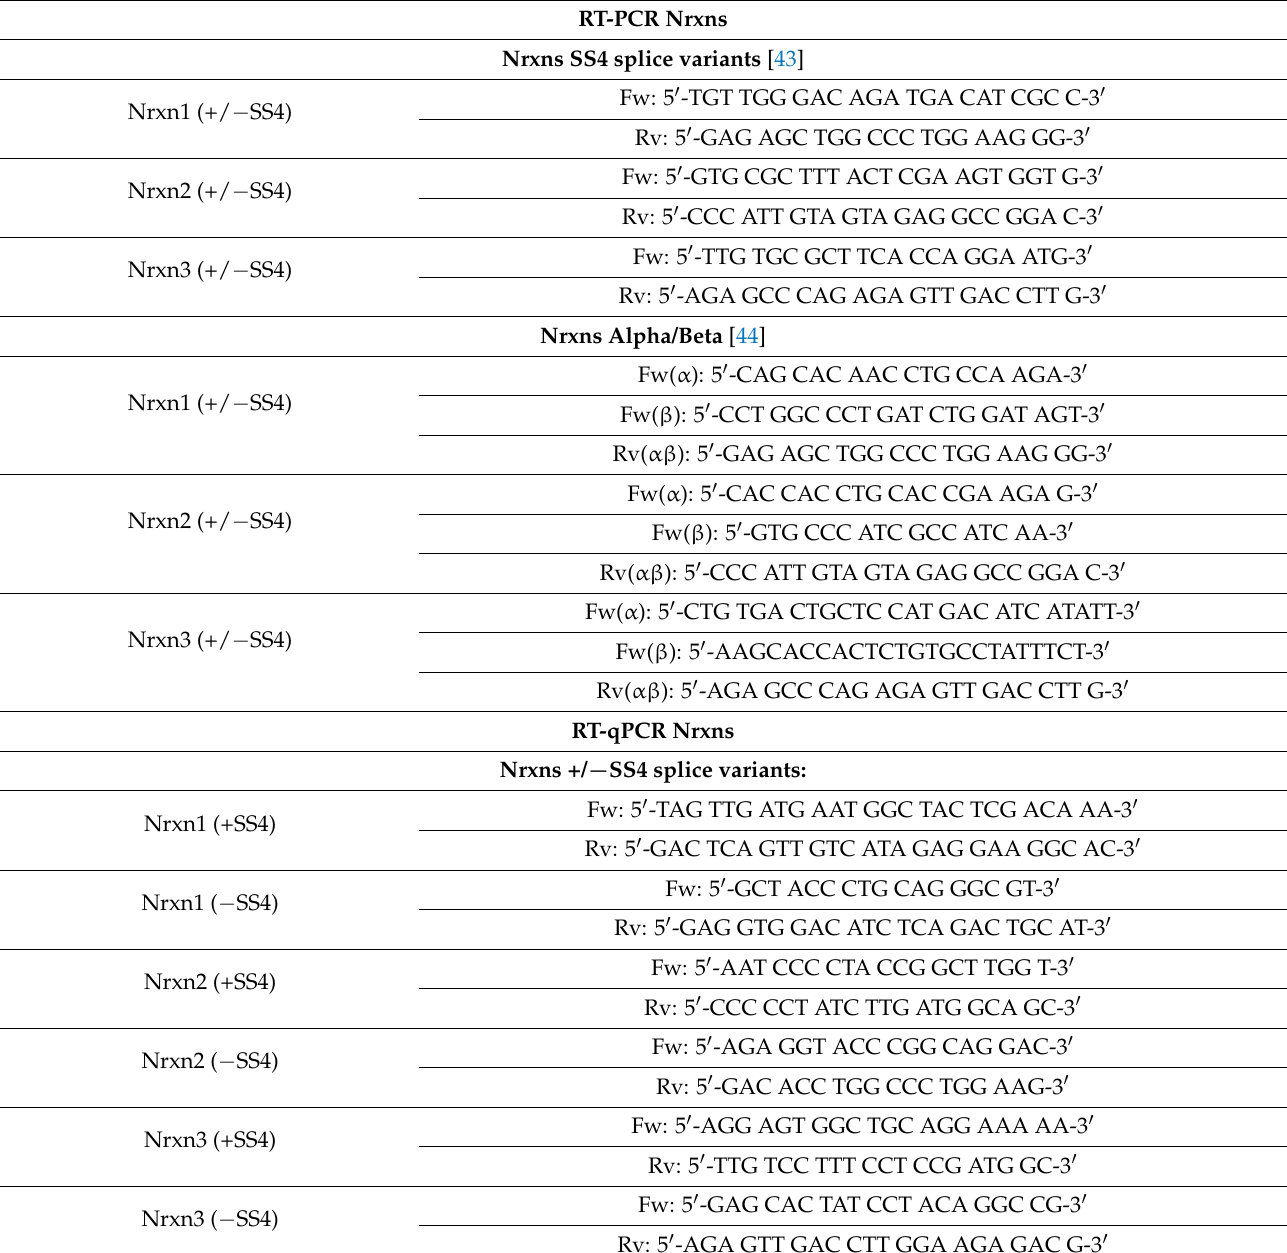
Table 1. List of